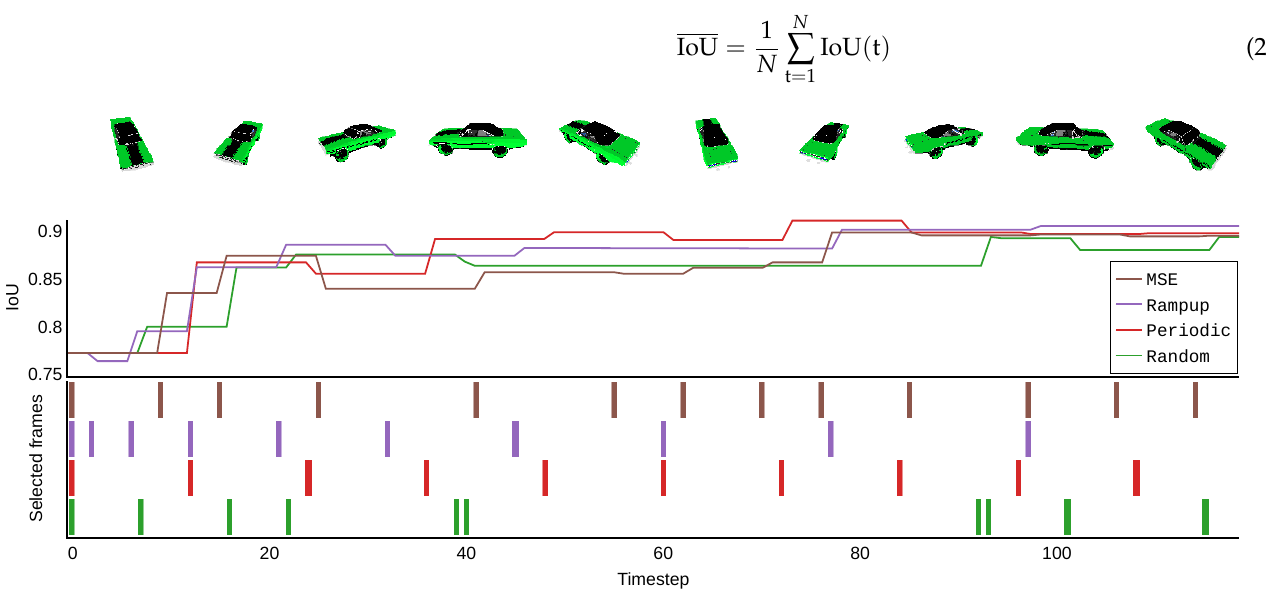
Figure 4. Principle of online, iterative 3D reconstruction. At each discrete timestep, an image is captured from a viewpoint that is in the immediate neighborhood of the previous viewpoint. When the viewpoint is selected, an updated reconstruction is calculated. The quality of this reconstruction is measured by the intersection over the union (IoU) of the produced reconstruction with the ground truth of the dataset. Different viewpoint-selection algorithms lead to different IoU curves, and not all images result in improved reconstruction quality. The selection methods are further explained in Section